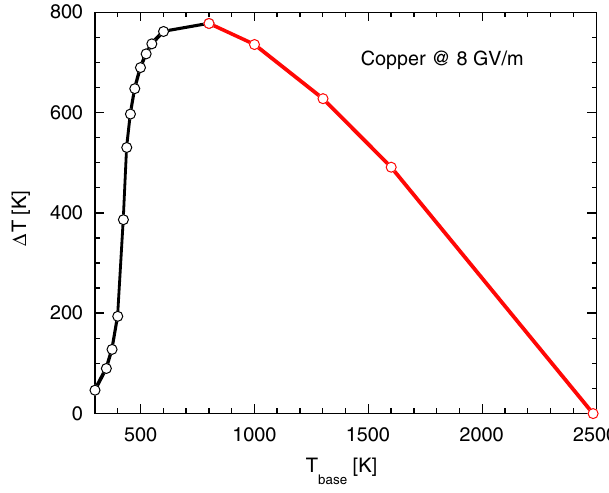
FIG. 17. (Color) Solutions to Eq. (26) for copperlike parameters, where (cid:1) T is the left-hand side and T temperature increases, (cid:1) T can increase markedly, even below the melting